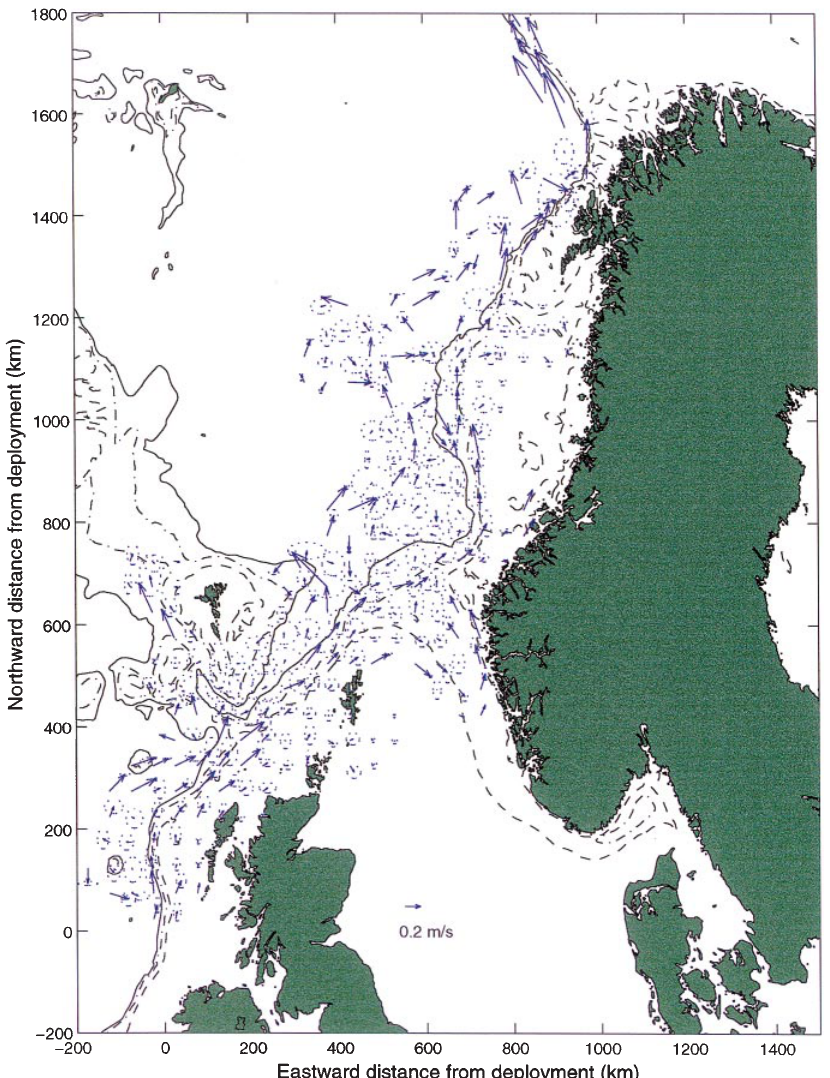
Fig. 7. Spatially averaged current vectors with associated first standard deviations in the point ellipse. Averages are made in 50 km boxes on Cartesian (north and east) axes through 180 days after the